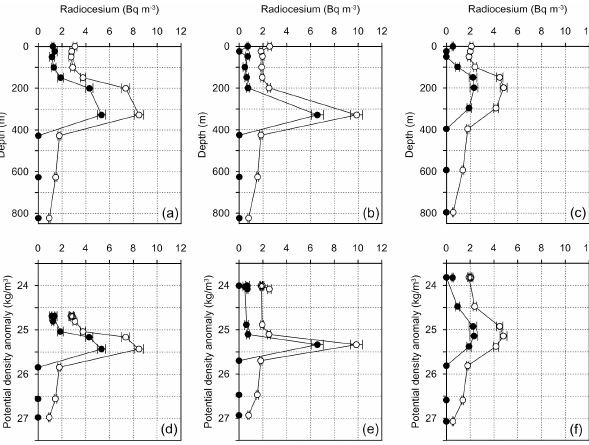
Fig. 3. Depth profiles of activity concentration of 134 Cs (closed cir- cles) and 137 Cs (open circles) at the three subtropical stations, 77 (a) , 71 (b) and 67 (c) , 10 months after the FNPP1 accident. Those are also plotted against potential density anomaly (kgm − 3 ) of the sampled seawater at the three stations, 77 (d) , 71 (e) and 67 (f) . Fig. 3. Kitamura et al. The potential density is the density a parcel of water would have if it were raised adiabatically to the surface without change in salin- ity. The potential density anomaly, σ θ (kgm − 3 ) , is calculated using Fig. 2. Horizontal distributions of radiocesium activity concentra- potential temperature ( θ) and salinity ( s ) as follows; σ θ ( s , θ , 0) tions in surface seawater and zooplankton in the western North Pa- = ρ (s,θ, 0 ) − 1000, where ρ indicates seawater density (kgm − 3 ) cific Ocean 10 months after the FNPP1 accident. (a) 134 Cs activity and 0 (zero) means “at sea surface”. All the activities were decay in surface seawater, (b) 137 Cs activity in surface seawater, (c) 134 Cs Fig. 2. Kitamura et al. corrected to the date of activity in the bulk zooplankton community, and (d) 137 Cs activity in the bulk zooplankton community. All the activities were decay corrected to the date of sampling.